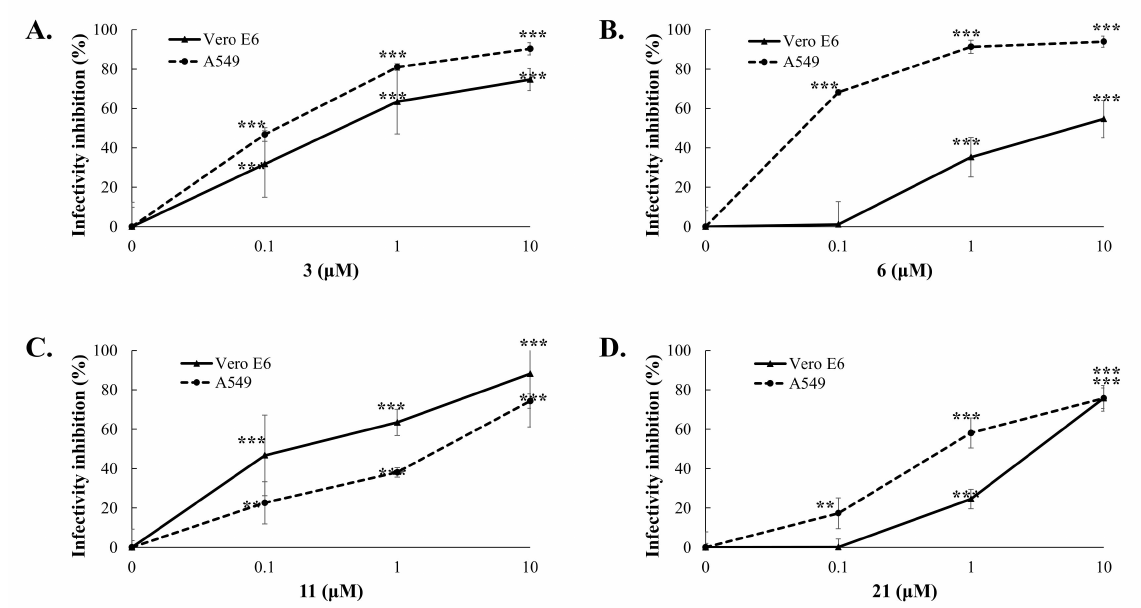
Figure 3. Infectivity inhibition of DENV2 in Vero E6 and A549 cells by active GL conjugates. Cells were infected with DENV2 in the presence and absence of Compounds 3 ( A ), 6 ( B ), 11 ( C ), and 21 ( D ) at concentrations of 0.1, 1, and 10 µ M, respectively. Treated/infected cells were also analyzed using immunofluorescence staining with anti-DENV2 NS4B antibodies. Residual infectivity was discovered by the ratio of DENV2 NS4B positive cells to total cells stained with DAPI, and relative inhibition activity was determined based on full infectivity with the subtraction of its residual infectivity. ** p value < 0.01; *** p value < 0.001 compared with untreated infected